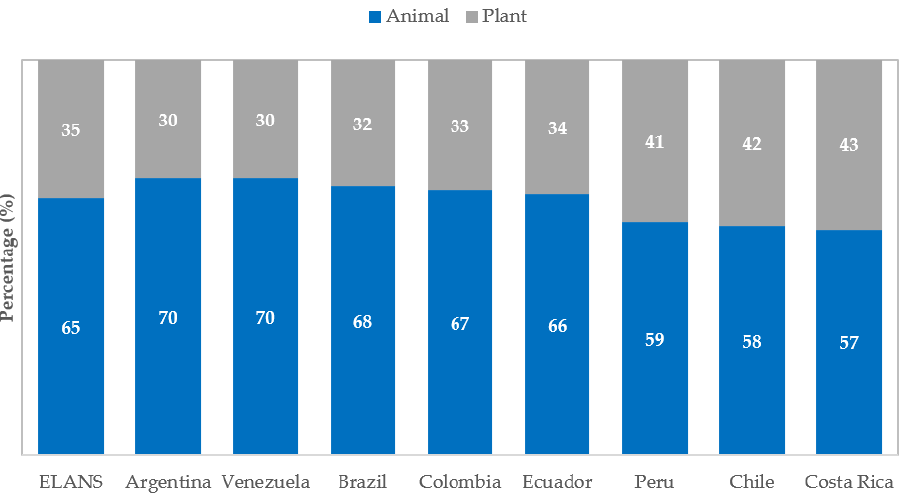
Figure 4. Proportionate intake of plant- and animal-based protein (as percentages) by ELANS